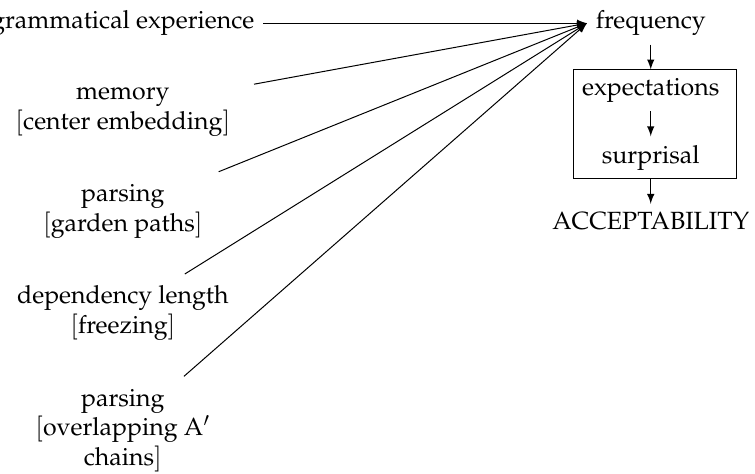
Figure 4. The logic of acceptability judgments for grammatical conditions, version